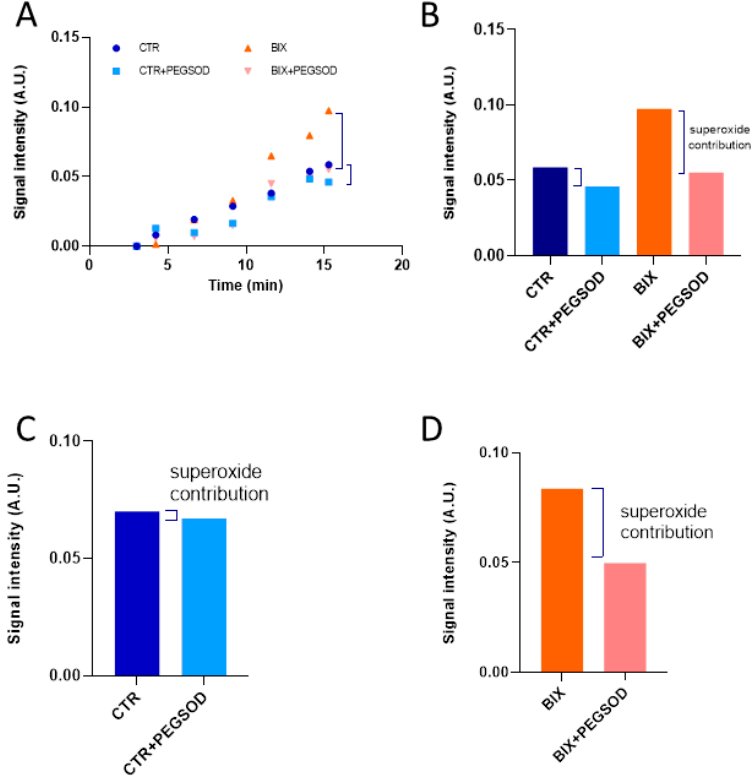
Figure 4. Illustration of the evaluation of mitochondrial superoxide assessment using EPR. Top row: typical experiment with exposure of HepG2 cells to Bixafen. A : Time course evolution of EPR signal intensity of mitoTEMPO° produced from mitoTEMPO-H. B : EPR signal intensity recorded for control cells and exposed cells 15 min after the start of the EPR experiment. The incubation with PEG-SOD2 allowed the evaluation of the superoxide contribution to the oxidation of the mitochondrial sensor. Bottom row: Mean values of EPR signal intensity at time t = 15 min recorded for 3 independent experiments. C : Control HepG2 cells. D : HepG2 cells exposed for 2 h to Bixafen.